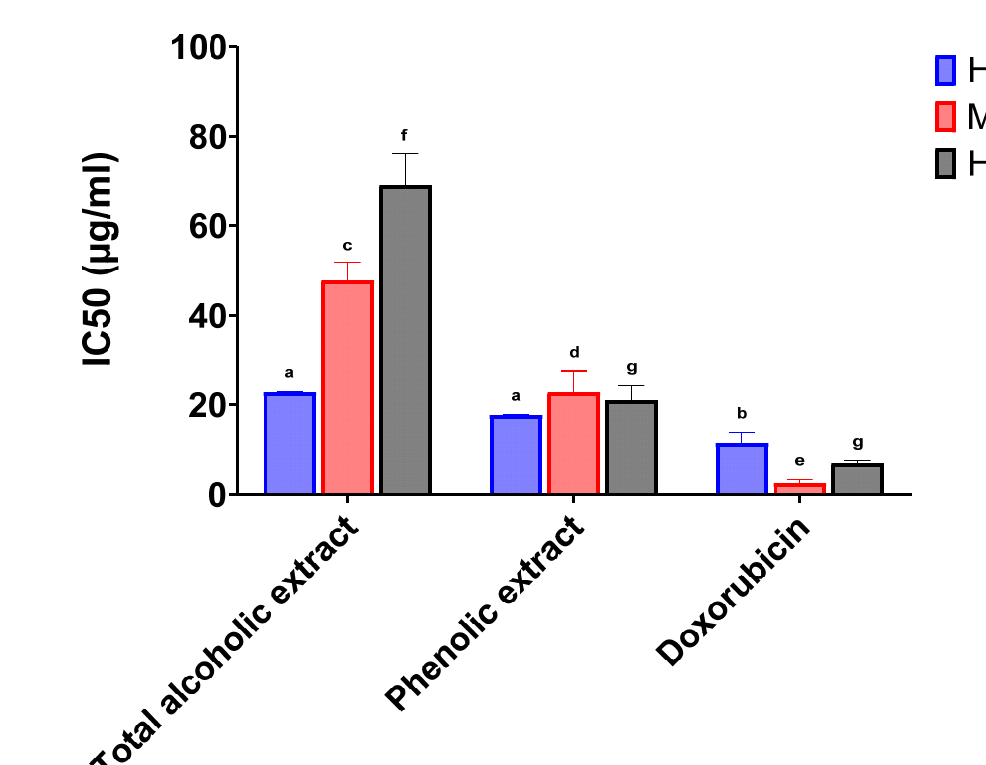
Figure 2. Anticancer activity of the total alcoholic extract and the phenolic extract of red cabbage leaves against HeLa, MCF-7, and HepG-2 cell lines. Bar graphs represent the mean ± SEM of 3 determinations (different letters above each column indicate statistically significant differences).